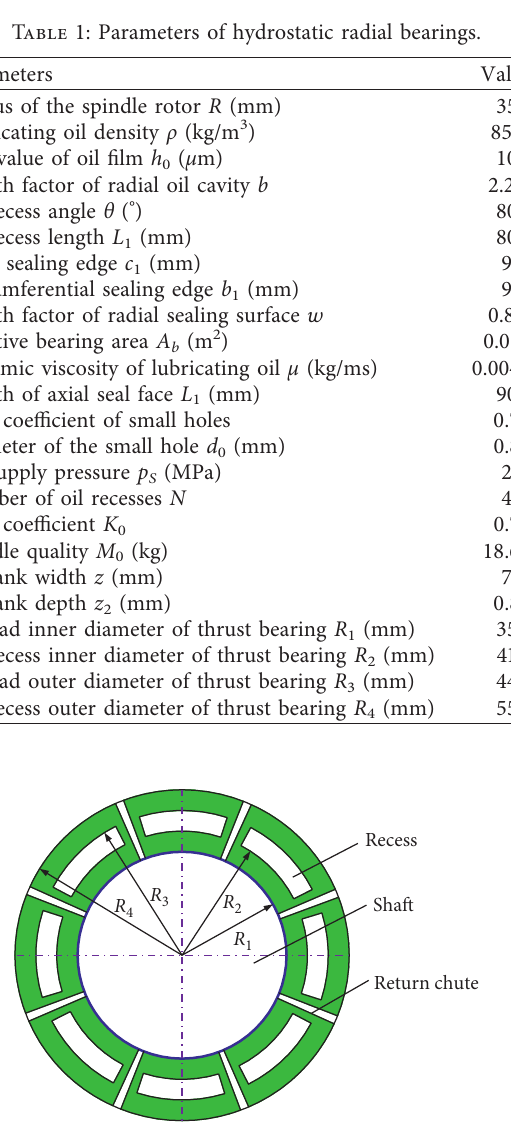
Figure 1: Structure of thrust